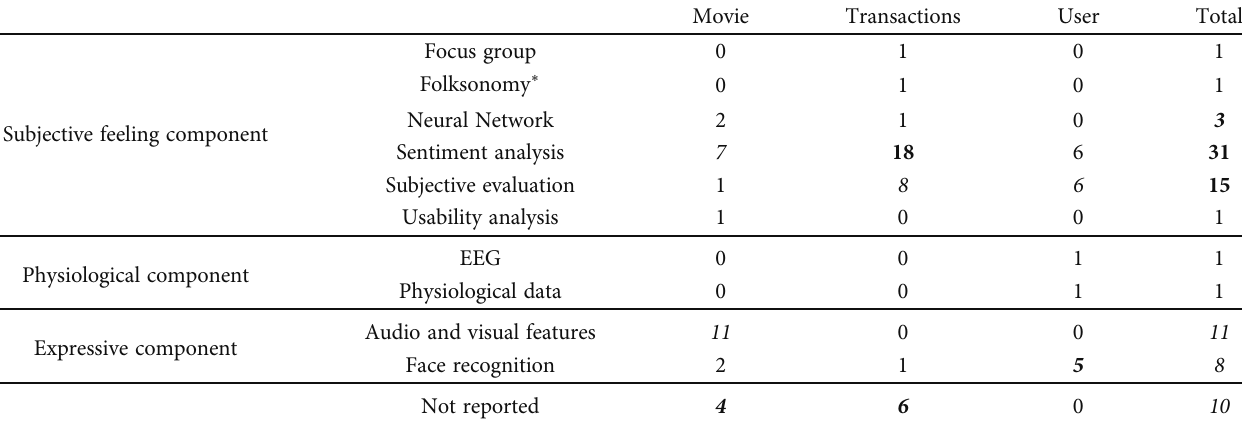
Table 7: Emotion identi fi cation method as a function of system information source.